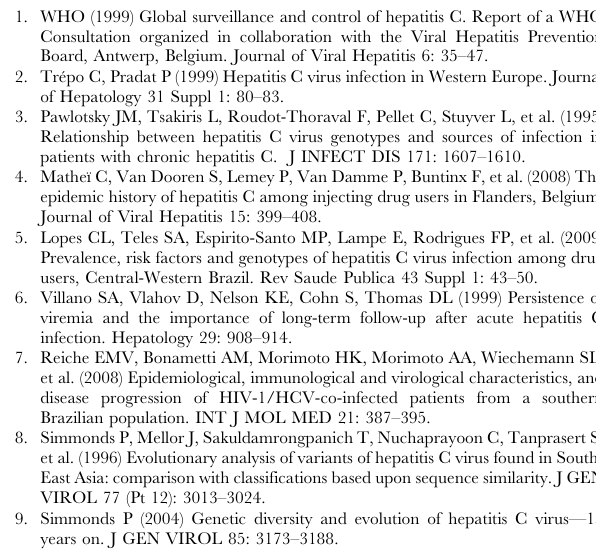
Table S1 Bayes factor values obtained for substitution models comparison. Figure S1 Maximum likelihood phylogenetic trees of HCV subtypes. Phylogenies were inferred using 335 sequences from HCV-1a, 499 sequences from HCV-1b and 252 HCV-3a sequences (i.e. a combination of those viruses sampled here and those collected from GenBank). Sequences sampled in this work are shown in phylogenies by colored branches, which indicate the four distinct localities in the State of Sa˜o Paulo: Ribeira˜o Preto (red), Sa˜o Bernardo do Campo (green), Sa˜o Paulo (blue) and Sa˜o Jose´ do Rio Preto (yellow). There was an evident lack of geographical structure in the data. Black branches correspond to global reference sequences collated from GenBank. As Brazilian sequences that fell within clusters of non-Brazilian sequences likely signify recent migration they were excluded from the subsequent phylodynamic analyses.